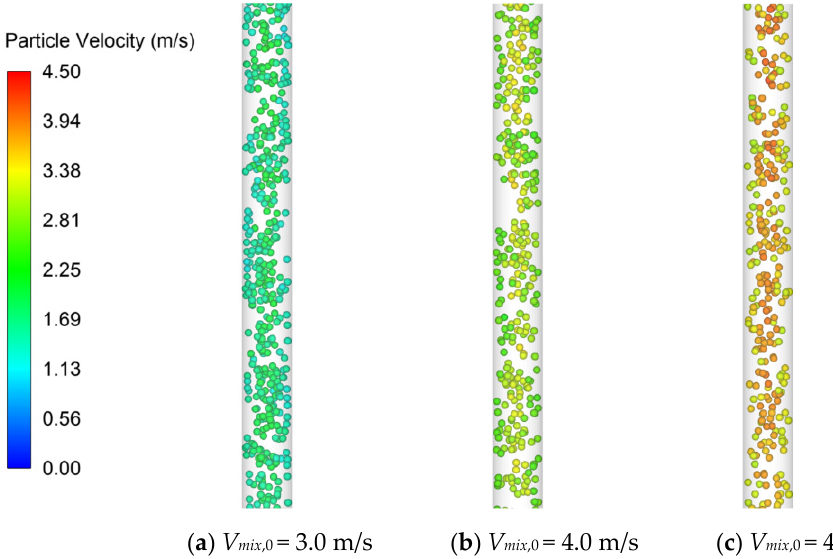
Figure 13. Instantaneous particle velocity distributions at different initial mixture velocities ( C v ,0 = 5%, d s = 15.0 mm).